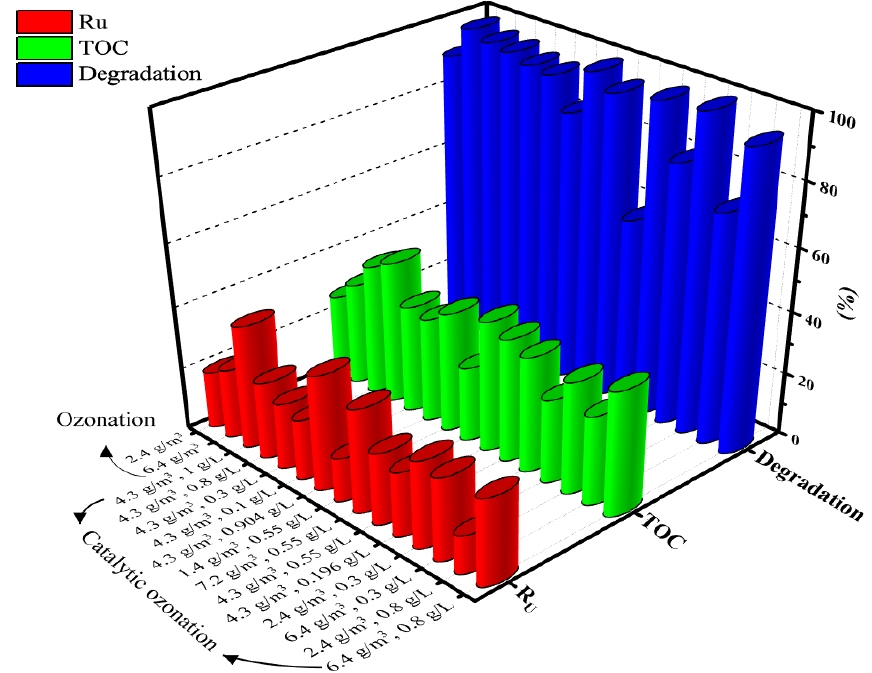
Figure 2. Degradation, mineralization, and R U percentages of the DCF through the ozonation and catalytic ozonation processes.